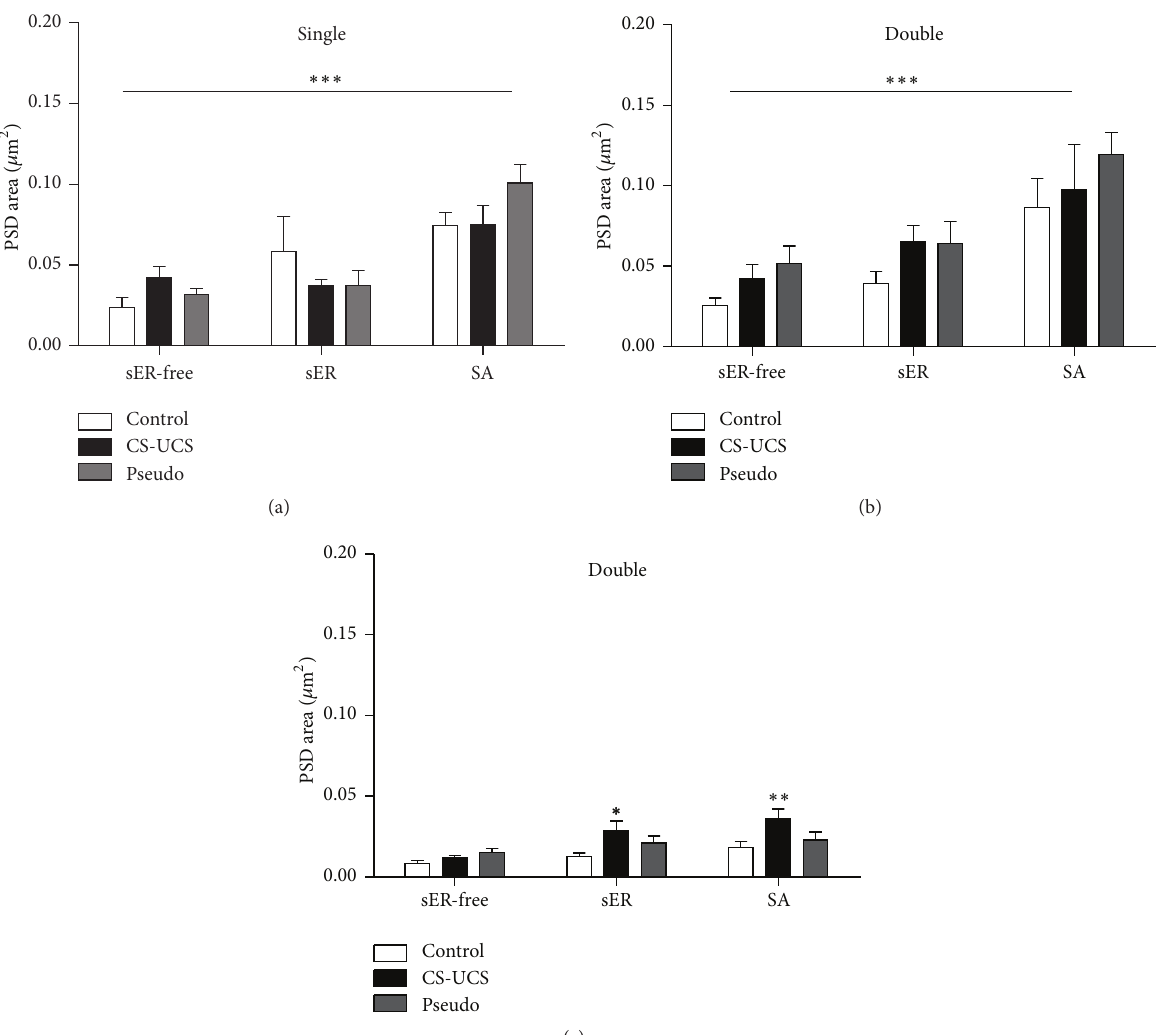
Figure 3: PSD area of excitatory ((a) and (b)) and inhibitory (c) synapses of single- and double-synapse spines: sER-free, containing sER, and containing SA. The graphs show means ± SEM (two-way ANOVA with post hoc Bonferroni test; ∗∗∗ 𝑃 < 0.001 , ∗∗ 𝑃 < 0.01 , and ∗ 𝑃 < 0.05 ).